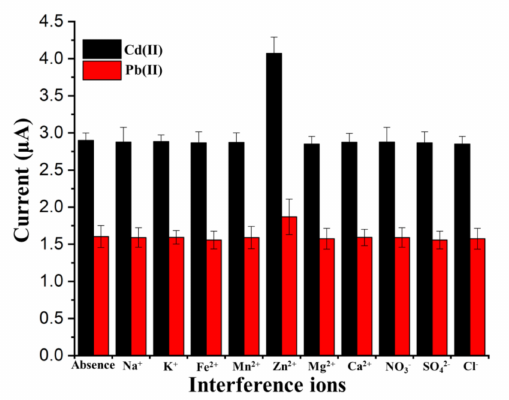
Figure 10. Interference study of high concentrations of di ff erent other ions on the stripping peak currents of 10 µ g / L Cd(II) and